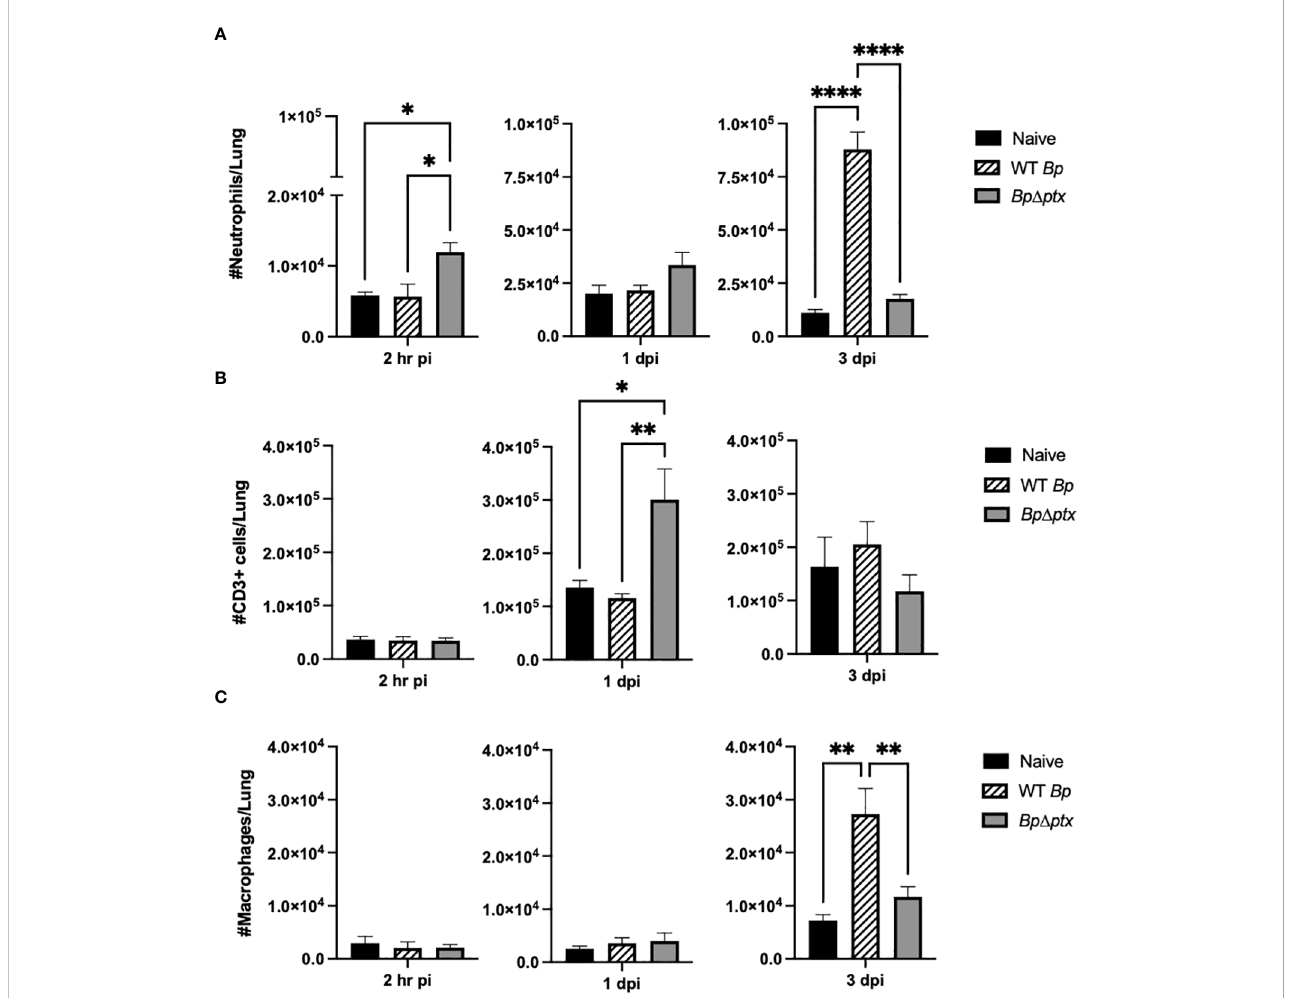
FIGURE 4 Pertussis toxin causes delayed neutrophil and T cell accumulation in the lungs of neonatal mice. Total neutrophils (CD45 + Ly6G + CD11b + ) in lungs of P5 C57BL/6J mice inoculated with WT Bp , Bp D ptx , or uninfected at 2 hours, 1 day, and 3 days post inoculation (A) . Total T cells (CD3 + ) in lungs of P5 C57BL/6J mice inoculated with WT Bp , Bp D ptx , or uninfected at 2 hours, 1 day, and 3 days post inoculation (B) . Total macrophages (CD45 + Ly6G - Siglec- F - MHCII + ) in lungs of P5 C57BL/6J mice inoculated with WT Bp , Bp D ptx , or uninfected at 2 hours, 1 day, and 3 days post inoculation (C) . Statistical analysis was calculated via Two-way ANOVA. Error bars show standard error of the mean (n=5). *p<0.0332, **p<0.0021, and ****p<